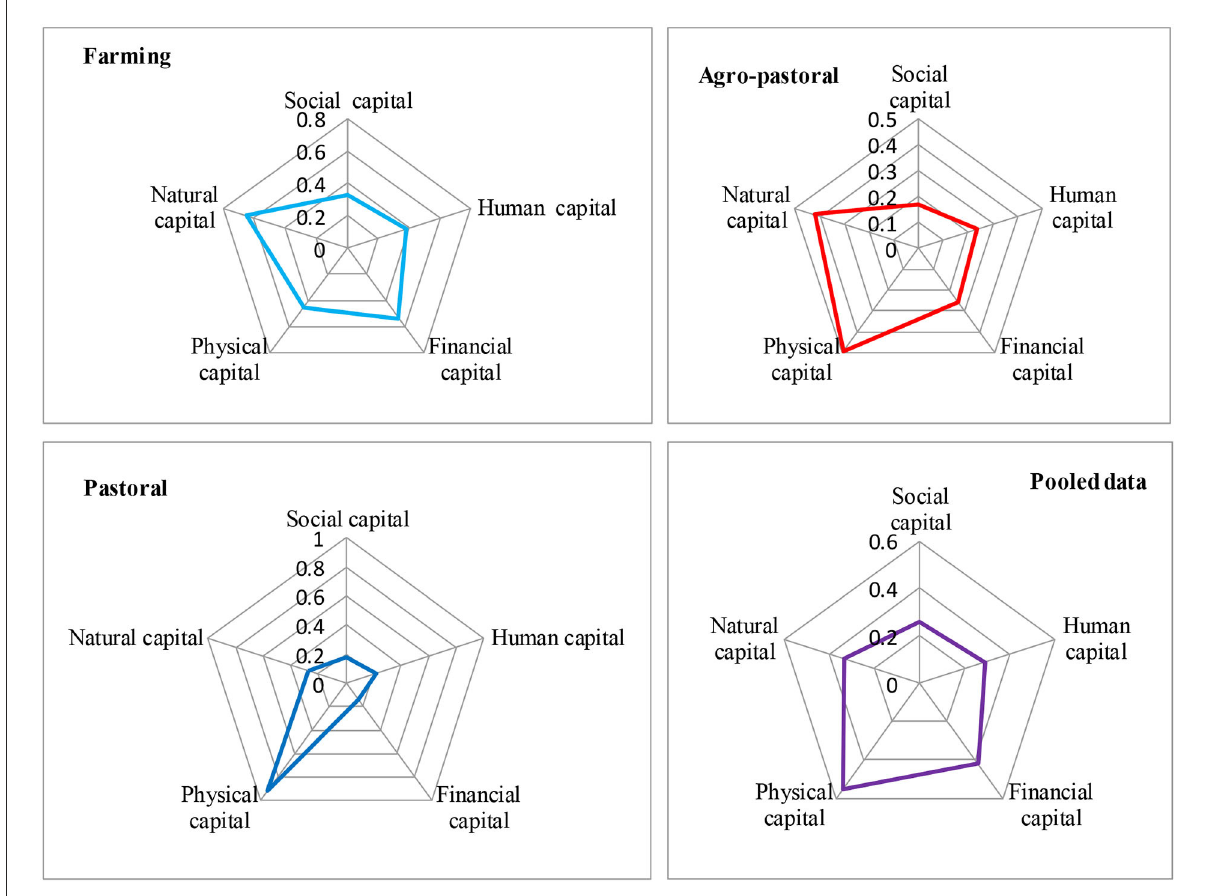
FIGURE2 Livelihood capital pentagons of the three livelihood group households.